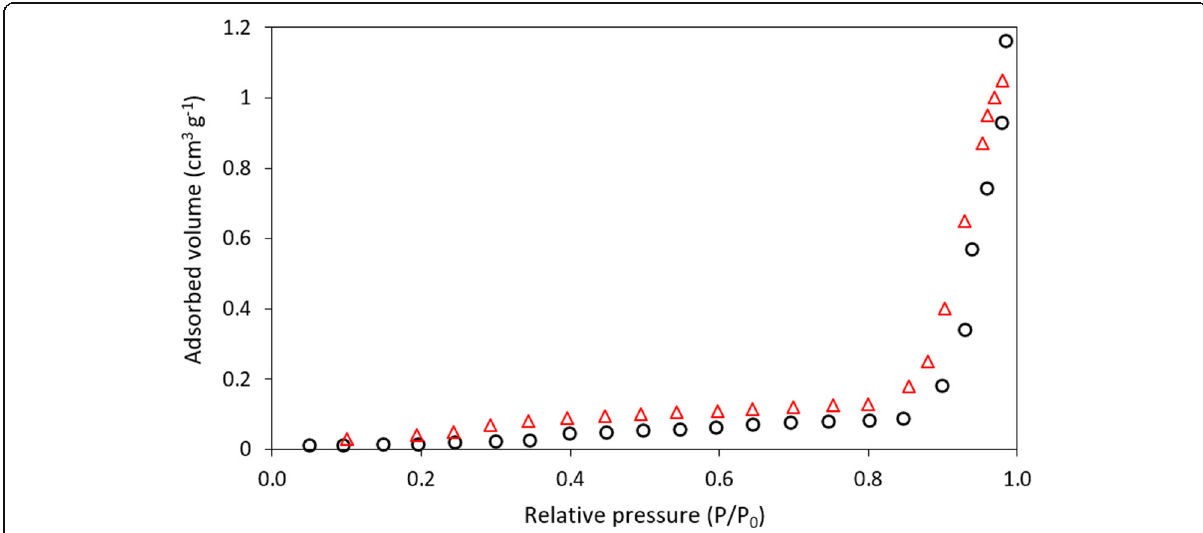
Fig. 1 N 2 adsorption-desorption isotherm for Nb 2 O 5 /Al 2 O 3 /Al monolith catalyst. Ref.: Adsorption, Desorption